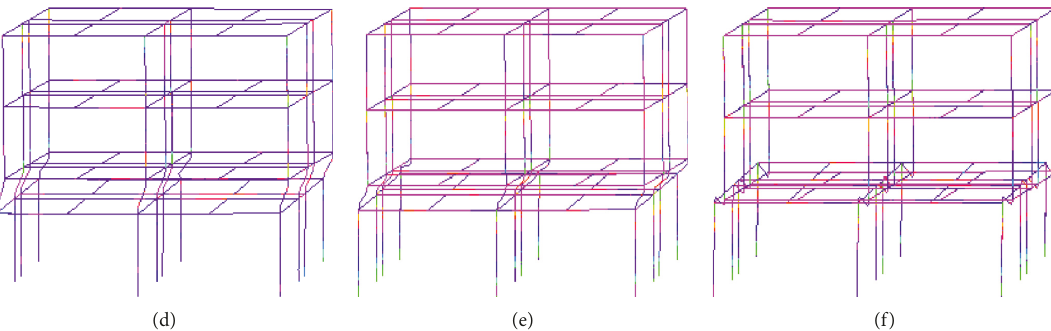
Figure 14: Collapse process of the structure subjected to three-component excitation under Tianjin wave considering strain rate effect. Table 6: Response summary of the structure subjected to three-component directional excitation. Rate-dependent model Earthquake wave